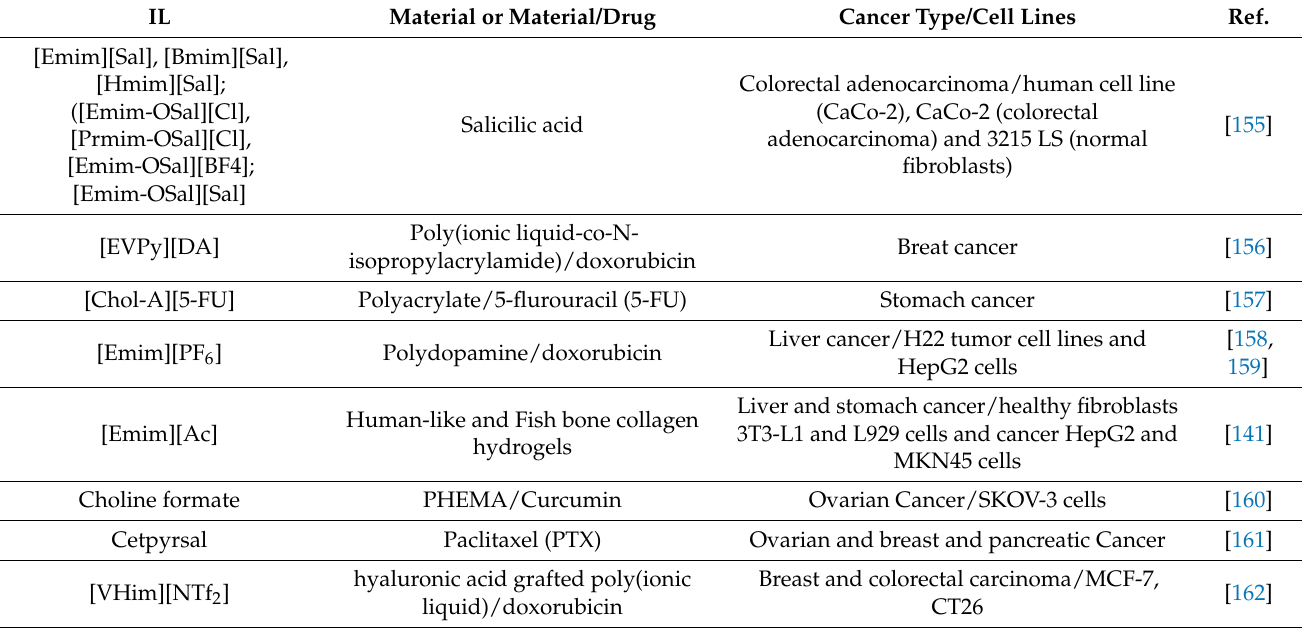
Table 3. IL and IL hybrid materials approaches evaluated for cancer therapy.